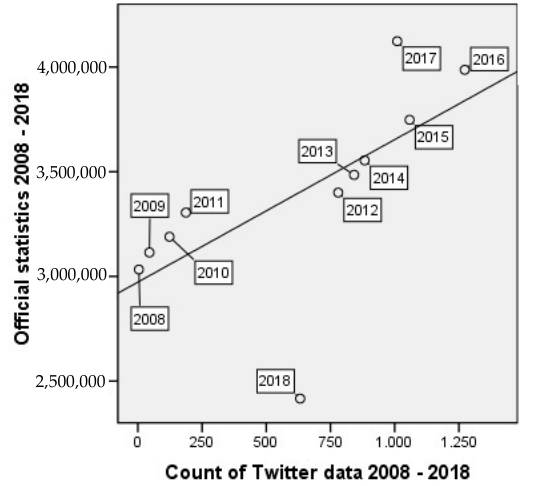
Figure 12. Scatter plot of official tourism and Twitter data distribution for the period 2008–2018. The x-axis denotes the absolute number of twitter data twitter data and the y-axis the absolute number of arrivals from the official statistics. R 2 is the coefficient of determination of the regression line.